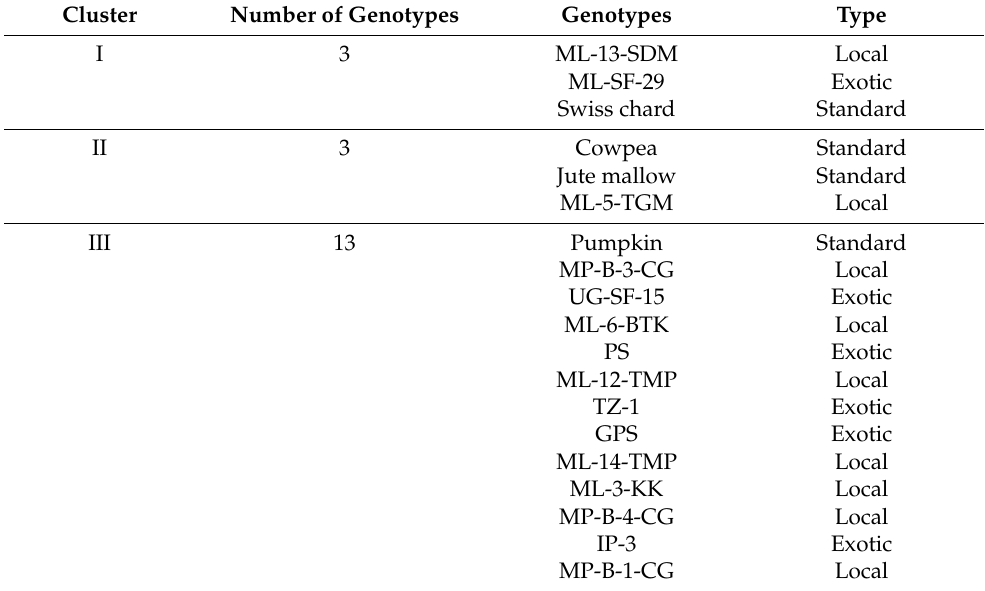
Figure 3. Complete linkage dendrogram showing existing groups in 15 spider plant accessions and four standards based on 12 variables for mineral content, total polyphenol count, and antioxidant activity. Table 8. List of clusters of 15 spider plant genotypes and four standards (swiss chard, jute mallow, cowpea, and pumpkin) according to cluster analysis.